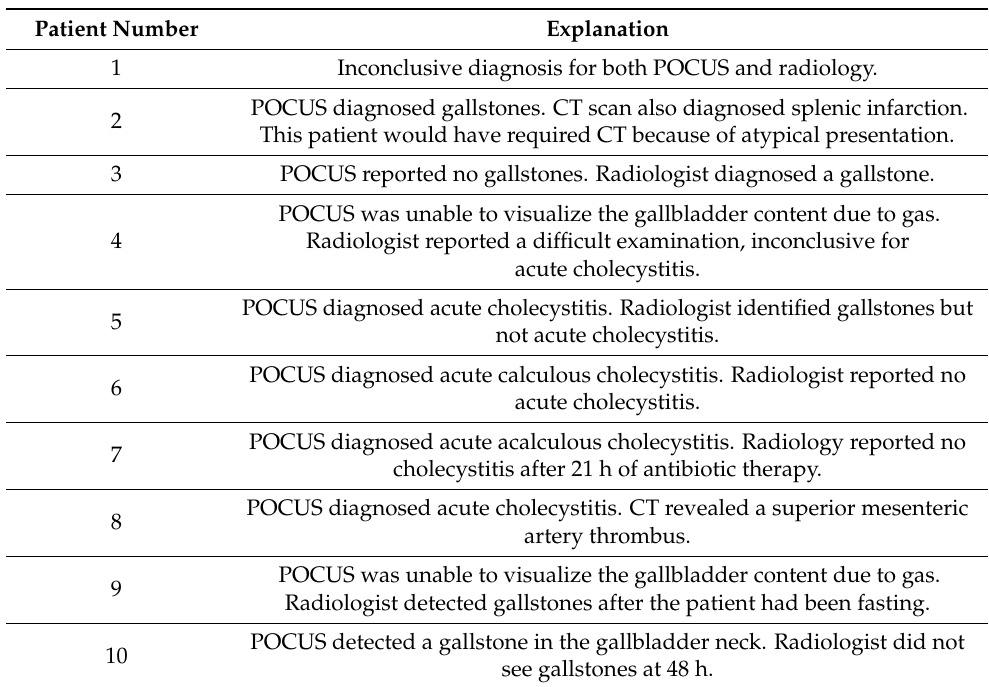
Table 3. Incidence of POCUS and radiology